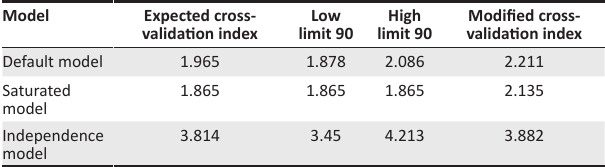
TABLE 6e: SEM model fit statistics. Model